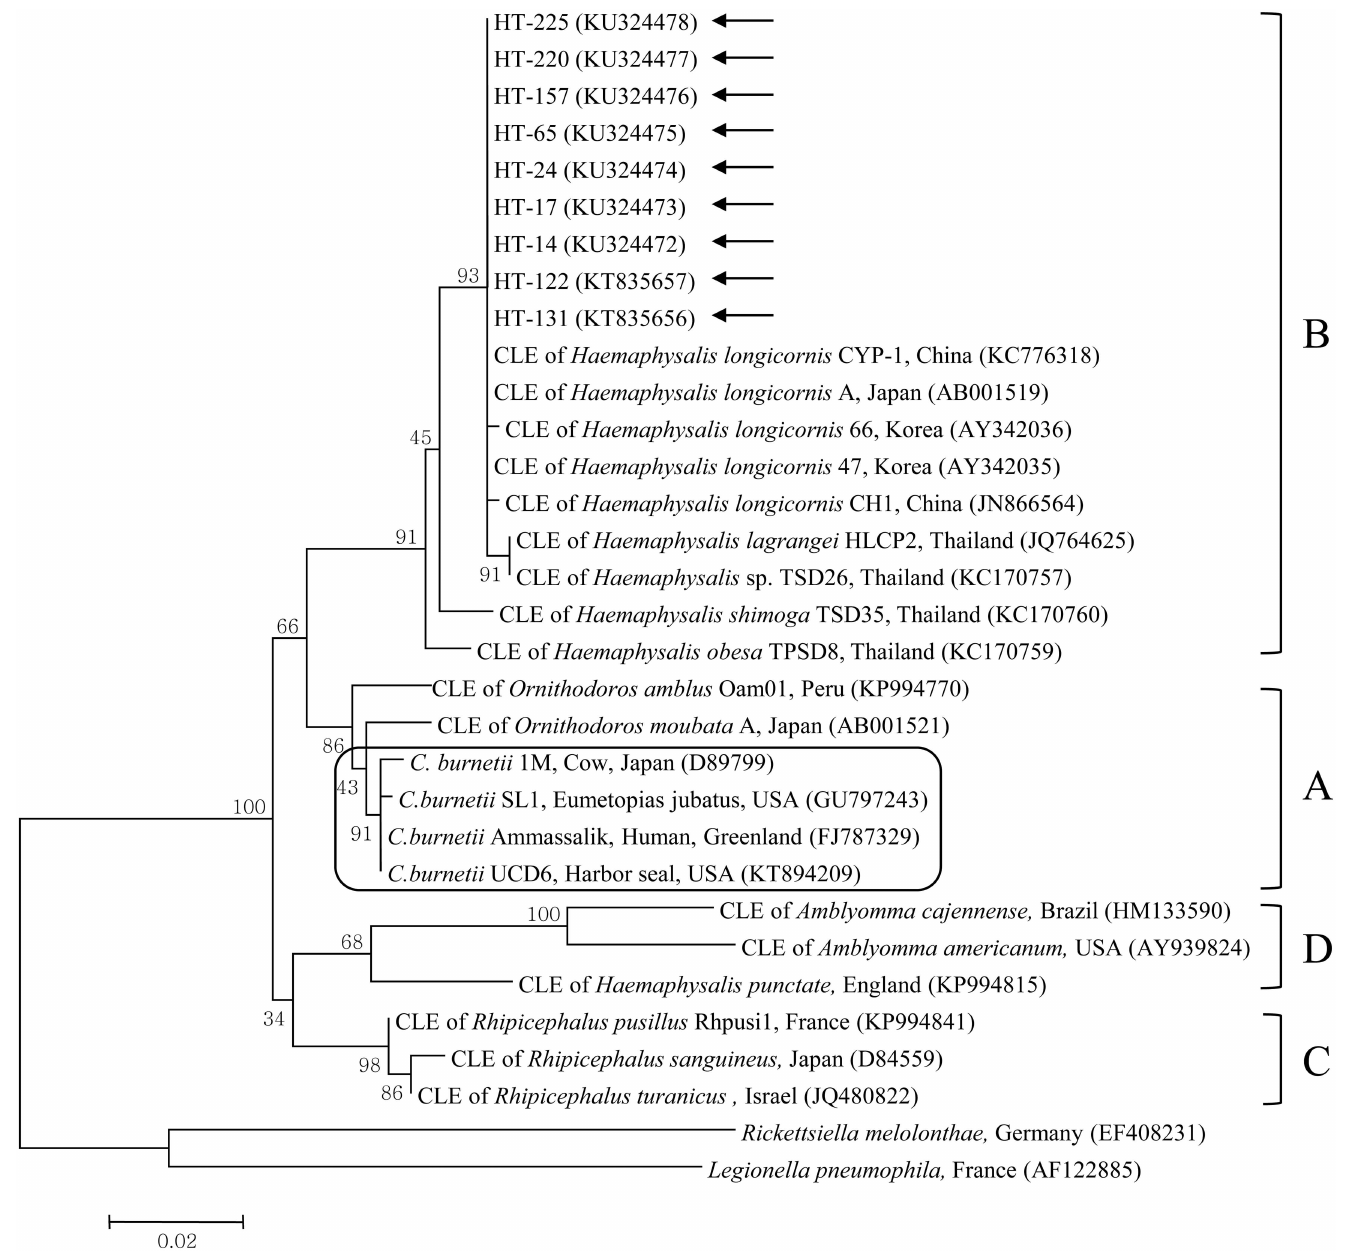
Fig 2. A phylogenetic tree constructed using the maximum likelihood method based on the 16S rRNA sequences of the genus Coxiella . Coxiella -like endosymbiont sequences analyzedin this study are marked by arrows. C . burnetii group is outlinedwithin clade A. Four clades of the genus Coxiella are labeledA to D. The accession numbers of other sequences from GenBank are shown with the sequence names and countries. The numbers on the branches indicate bootstrap support (1,000 replicates). Scale bar shows the phylogenetic distance between sequences equivalent to 0.02 nucleotide substitutions per site. CLE = Coxiella -like